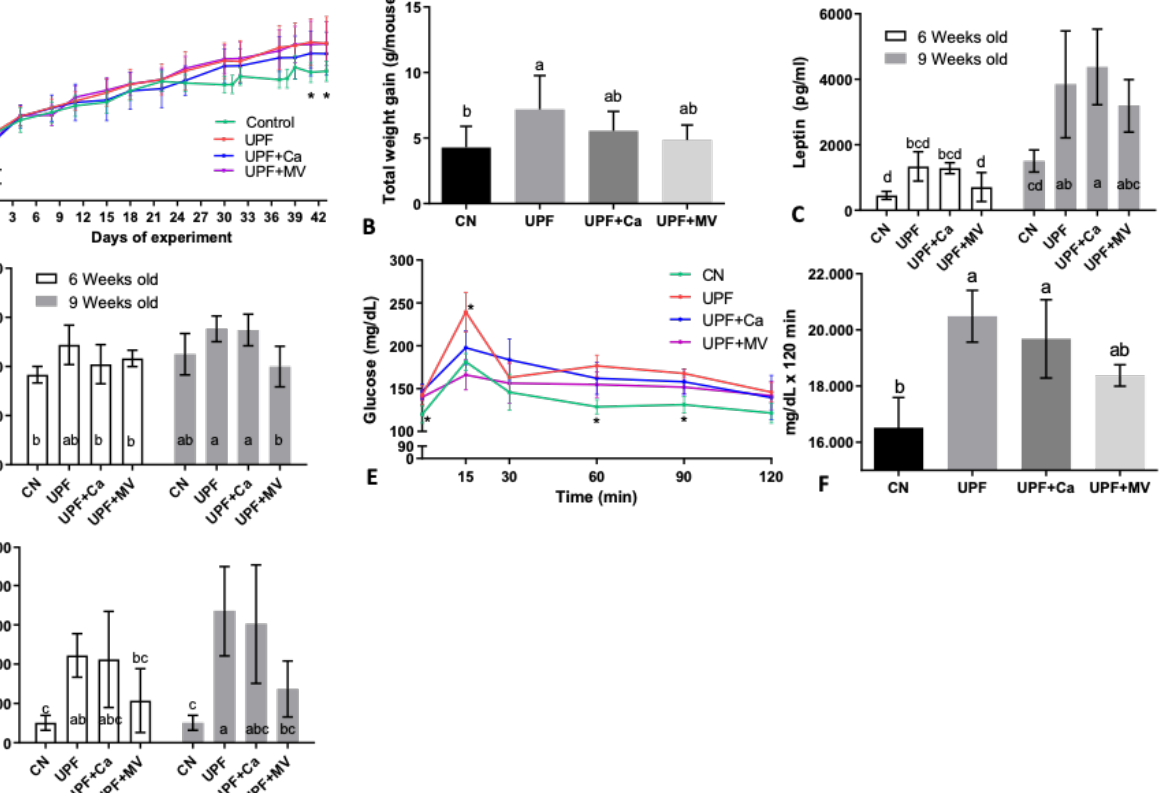
Figure 1. UPF effect on metabolic condition of mice at 6 and 9 weeks of age. ( A ) Weight throughout the experiment (gr) * refers control to UPF group only ( B ) Total weight gain throughout the experiment (gr/mouse) ( C ) Serum leptin (pg/mL) ( D ) Serum glucose (mg/dL) ( E ) IPGTT Intra peritoneal glucose tolerance test (mg/dL/min) at age of 6 weeks ( F ) Average area under the curve of IPGTT (intraperitoneal glucose tolerance test) (mg/dL × 120 min) ( G ) Serum insulin (pg/mL). Values are expressed as mean ± SD, n = 8. Different letters denote p < 0.05 between groups, * p < 0.05 compared to control. CN – control, UPF – ultra processed food, UPF+Ca - ultra processed food supplemented with calcium, UPF+MV - ultra processed food supplemented with multivitamin and mineral complex.